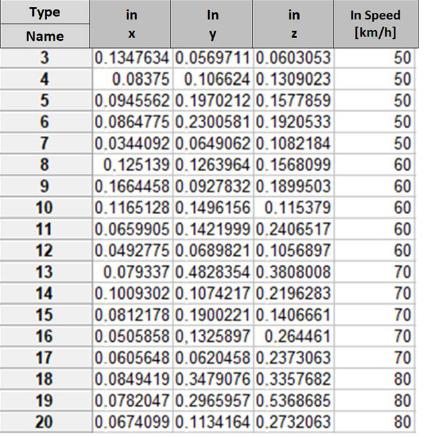
Figure 16. View of the data fragment in the expert system — input data (in).